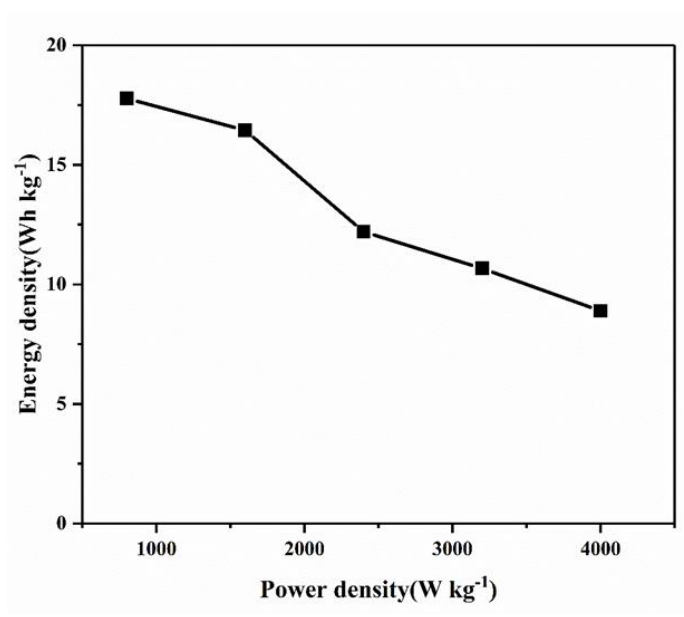
Figure 10. Ragone plots of the symmetrical